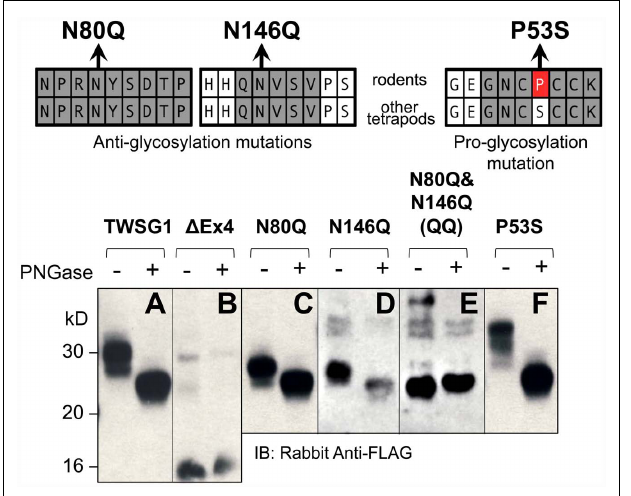
FIGURE 2 |Twisted gastrulation in rodents is N -glycosylated at two residues, both in exon 4. (Top) Locations of mutations that remove or add glycosylation at conserved sites are shown with reference to the sequences in rodents and other tetrapods. (A) Wild type mTWSG1 is glycosylated and runs on SDS-PAGE as a doublet of about 27kD and 30kD. (B) Exon 4-deleted mTWSG1 is not glycosylated. (C) The N80Q mutation removes one glycosylation site but is still glycosylated. (D) The N146Q mutation removes one glycosylation site but the protein is still glycosylated. (E) When the N80Q and N146Q mutations are combined the resulting QQ-TWSG1 is not glycosylated. (F) Mutation of a proline in mTWSG1 to the consensus serine restores a third glycosylation site.